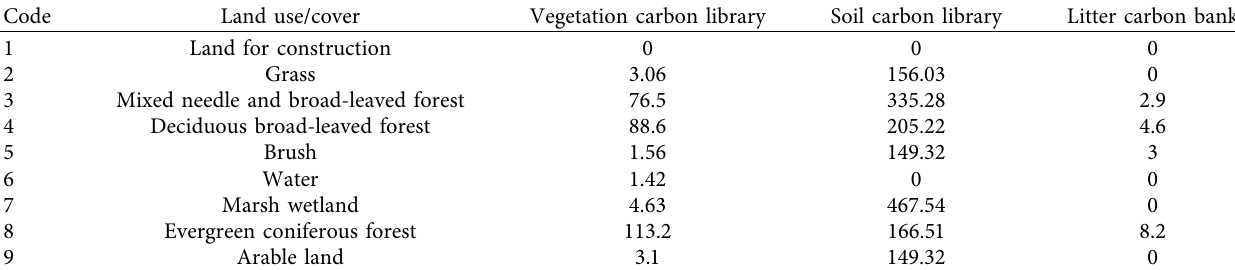
Table 3: Carbon density values of different land use/cover types in Dabanhe wetland (t · hm − 2